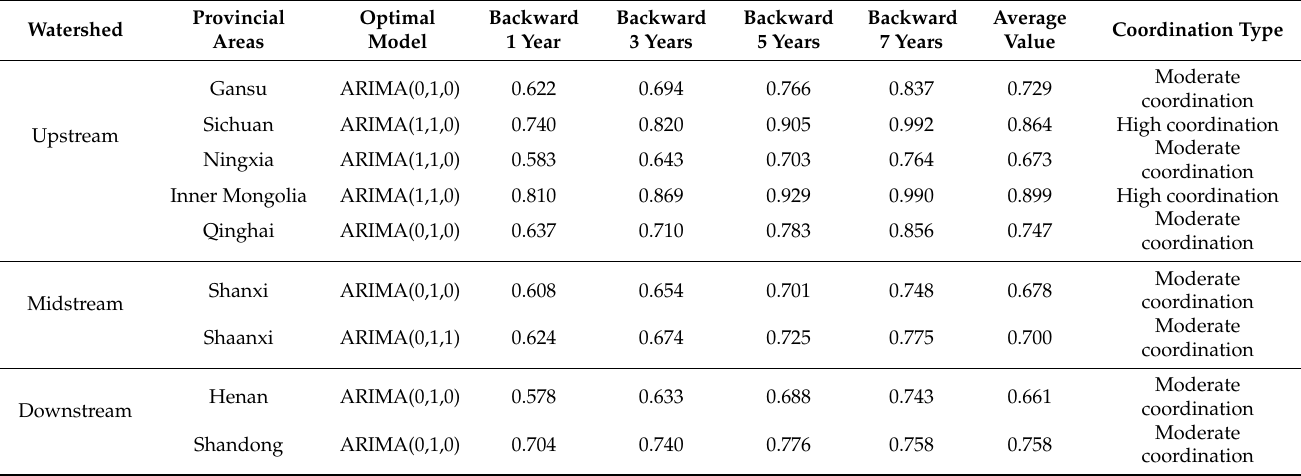
Table 7. ARIMA prediction results.